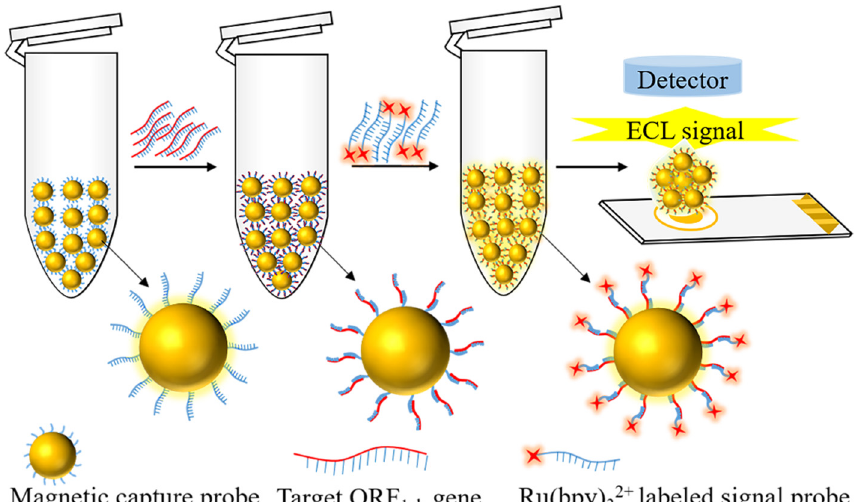
Figure 1. The schematic for detecting SARS-CoV-2 ORF1ab gene through the use of the ECL biosensor, based on dual-probe hybridization.